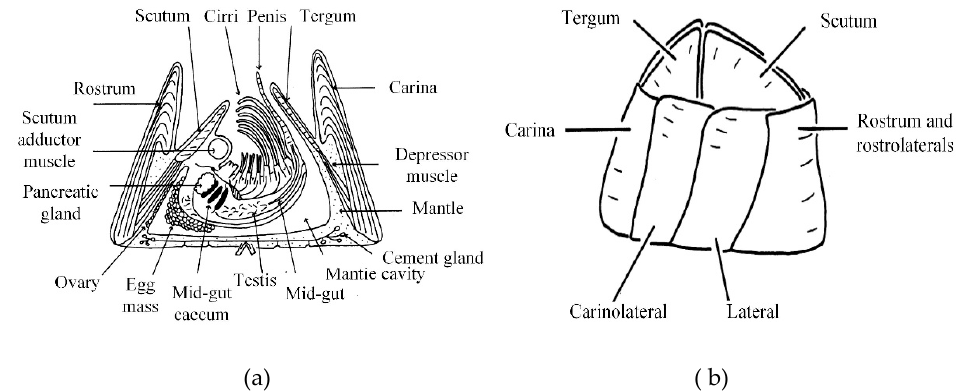
Figure 1. Anatomic structure ( a ) and 3D profile ( b ) of barnacle. Figure 2. The cross-section of a barnacle on a foreign substratum.